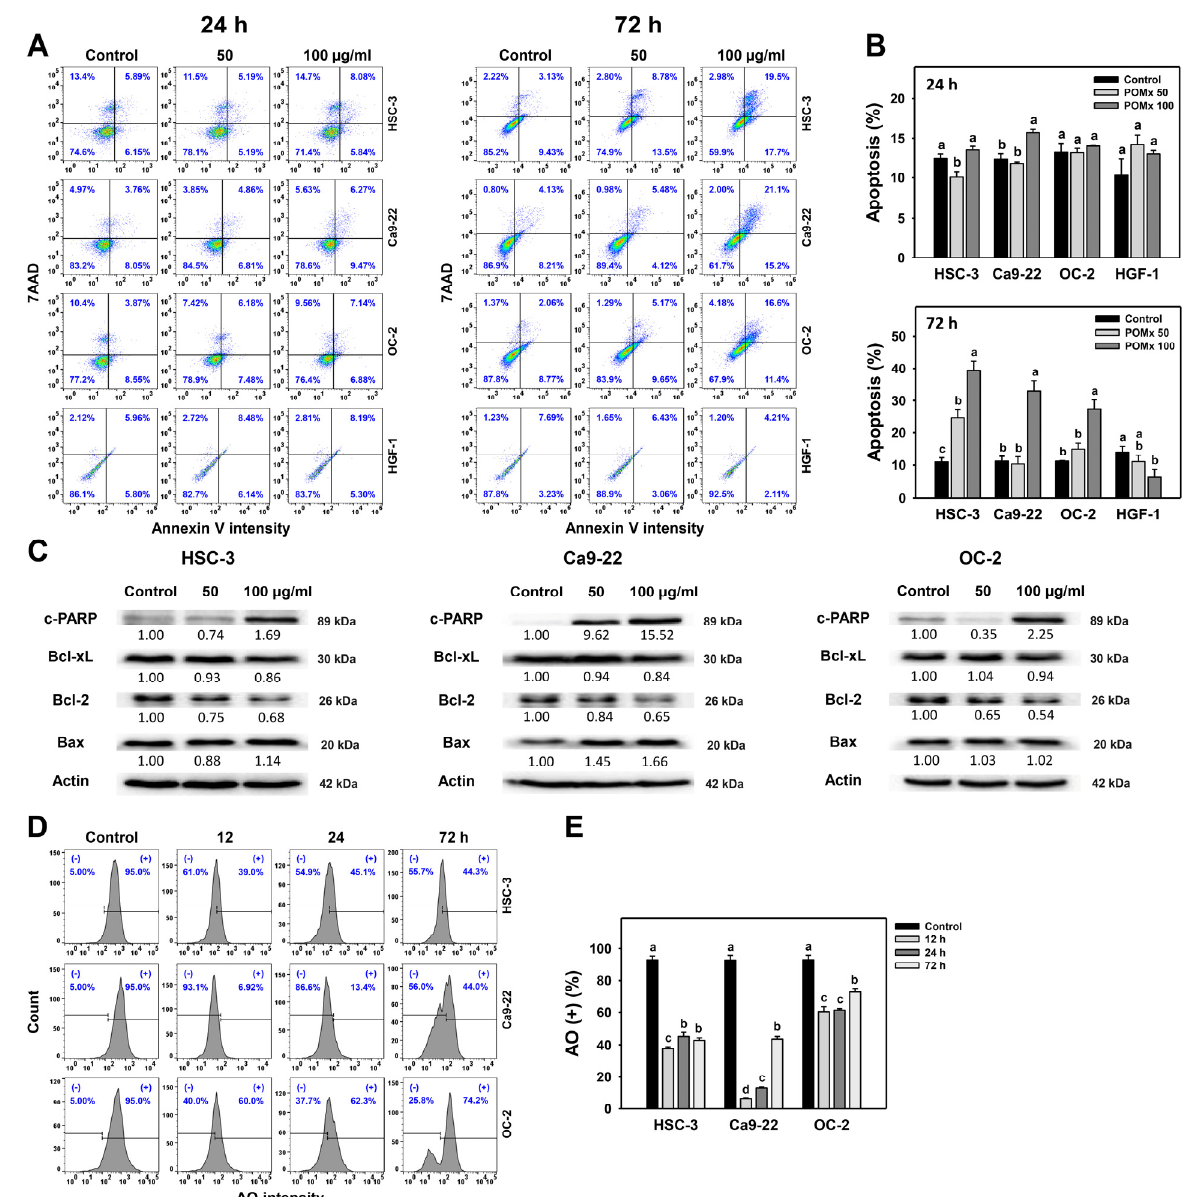
Figure 4. Apoptosis and autophagy changes of oral cancer cells after POMx incubation. Cells (HSC-3, Ca9-22, and OC-2) were incubated with control, 50, and 100 µ g/mL of POMx (control, POMx 50, and POMx 100) for 24 and 72 h. ( A ) Annexin V/7AAD flow cytometry patterns. ( B ) Statistics for ( A ). ( C ) Western blotting for apoptosis marker expressions after 72 h POMx (0, 50, and 100 μ g/mL) incubation. ( D ) Acridine orange (AO) flow cytometry patterns at 0, 12, 24, and 72 h for 100 µ g/mL POMx incubation ( E ) Statistics for ( D ). Treatments without overlapping low cases (a to d) are significant differences for the same cell type. p < 0.001. Data, mean ± SD ( n =